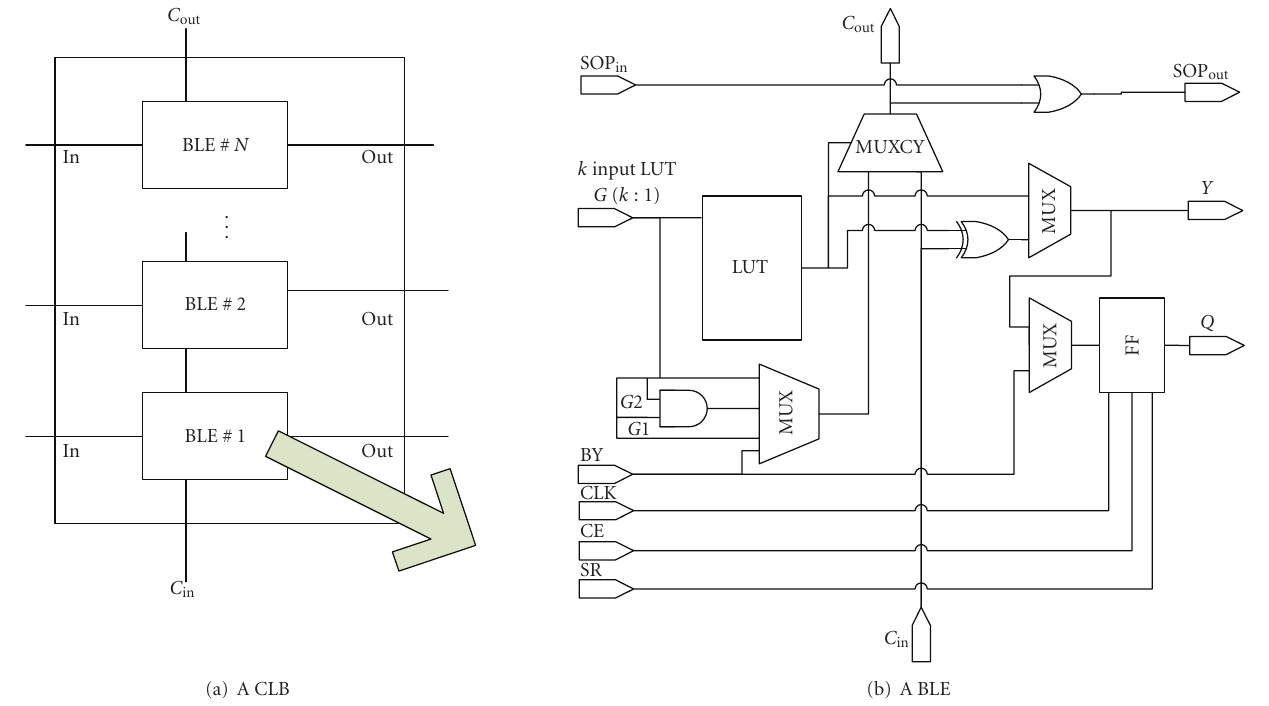
Figure 1: A configurable logic block and the basic logic element